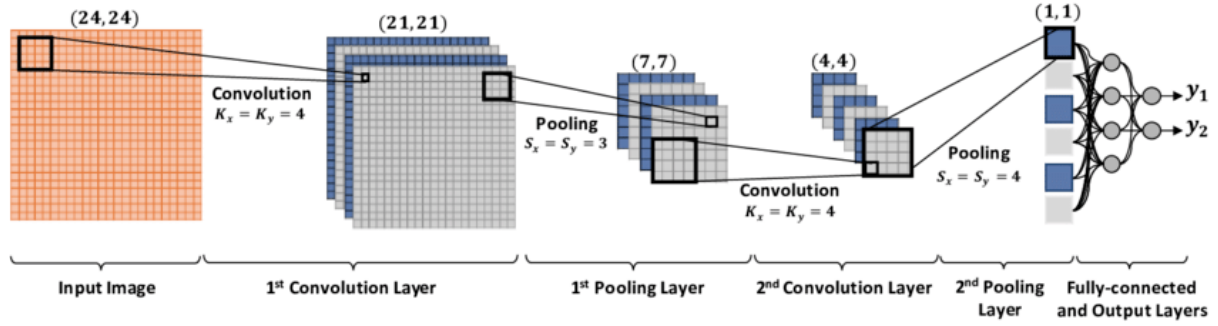
Figure 7. The illustration of a sample CNN with two convolutions and one fully connected layer [88].